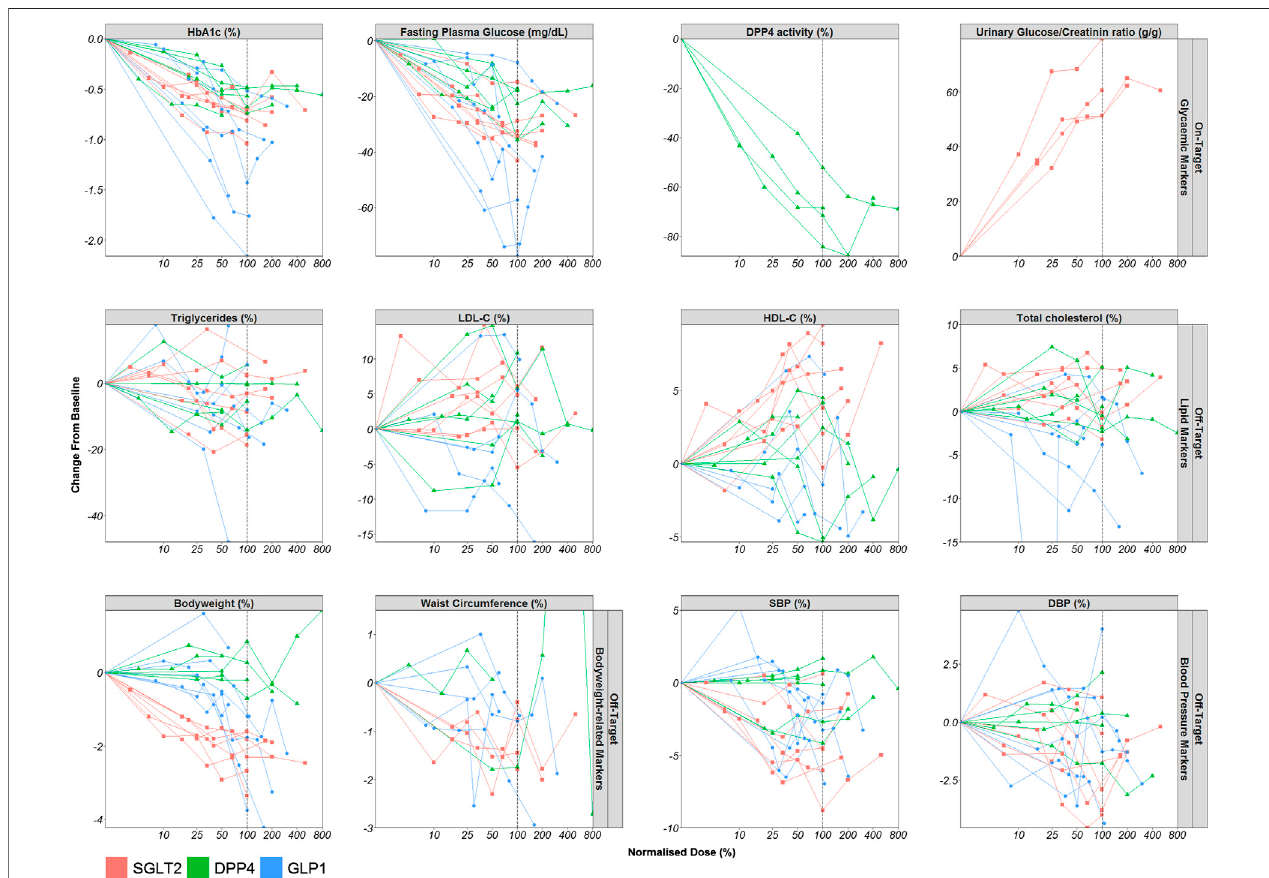
FIGURE 4 | Dose-Response relationship of markers of the on- and off-target drug effects. Mean observed dose-normalised drug effect (o) per dose level are displayed for all included dose- fi nding trials (lines). Abbreviations: Diastolic blood pressure (DBP), dipeptidyl peptidase-4 (DPP4), fasting plasma glucose (FPG), glucagon-like peptide-1 (GLP1), glycated hemoglobin (HbA1c), high-density lipoprotein cholesterol (HDL-C), low-density lipoprotein cholesterol (LDL-C), sodium- glucose co-transporters -2 (SGLT2), systolic blood pressure (SBP).